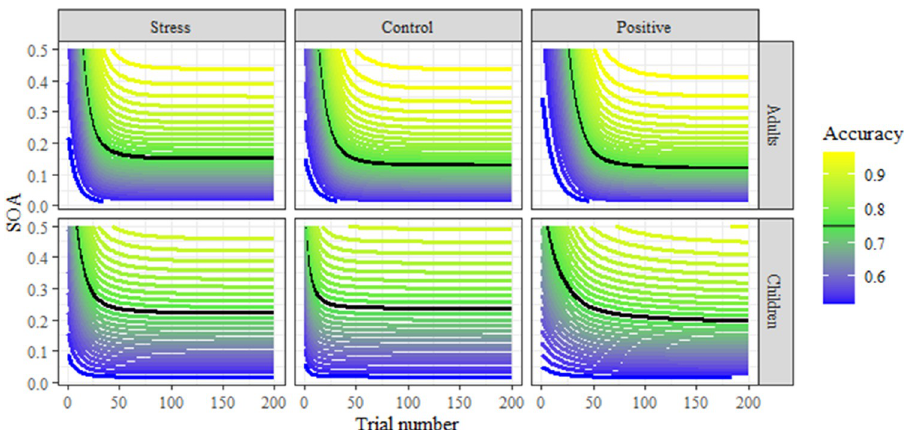
Fig 3. Group-level learning curves of the full model fitting monotonic effects of arousal as well as binary effects of age and valence. Contour lines represent levels of accuracy, with smaller SOA for a given accuracy indicating superior performance (i.e., contours lower on the Y axis indicate equal performance at shorter presentation times). The fit threshold value (75%) is indicated as a black contour, with a decrease over time in threshold evident in each group (i.e.,